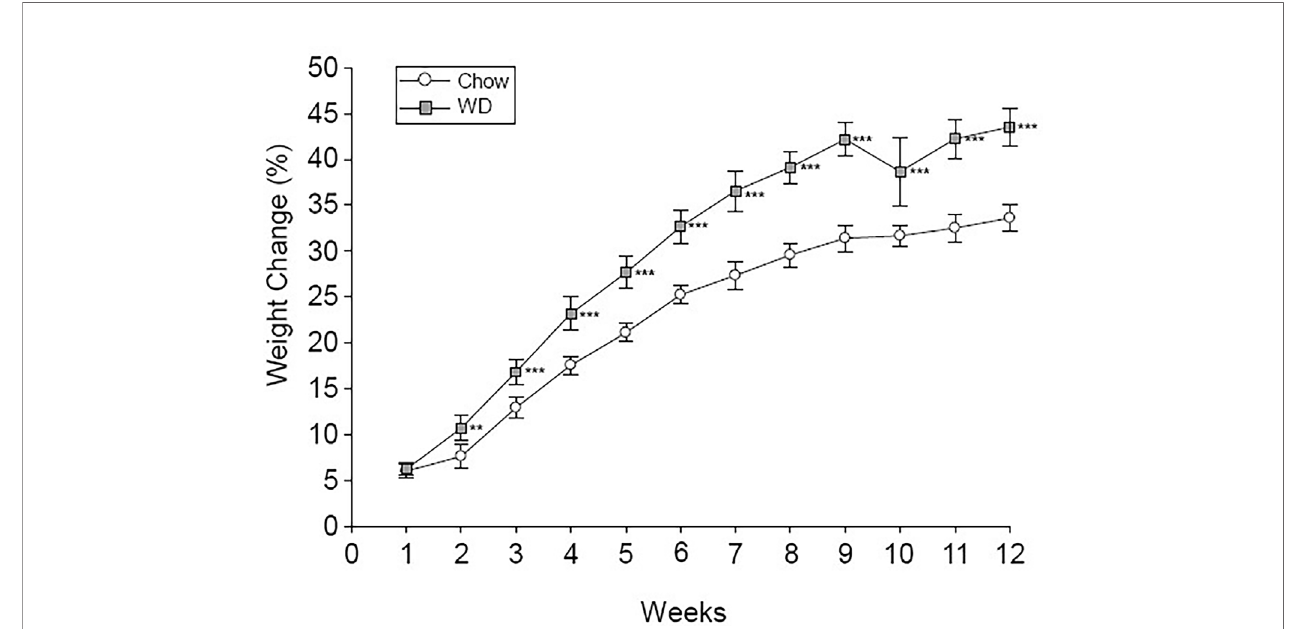
FIGURE 1 | Percent body weight change. Weekly percent weight change over time is shown for the Chow and WD groups. Group differences over the course of dietary treatment were analyzed by ANOVA. All data points are shown as group mean ± SE. (**p < 0.01, ***p < 0.001 compared to Chow).